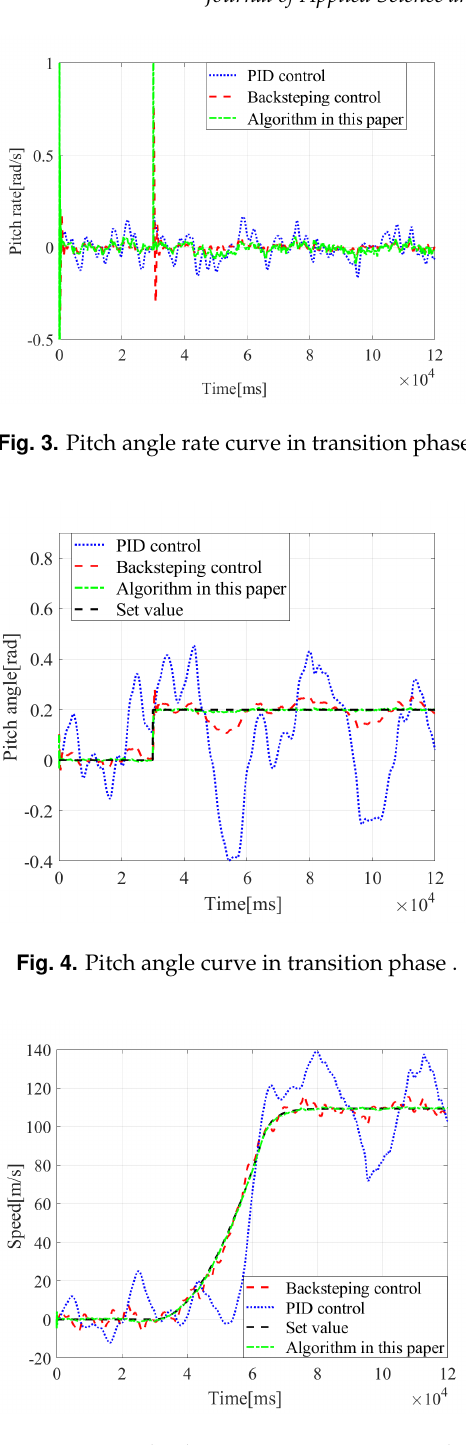
Fig. 5. Horizontal velocity curve in transition phase.